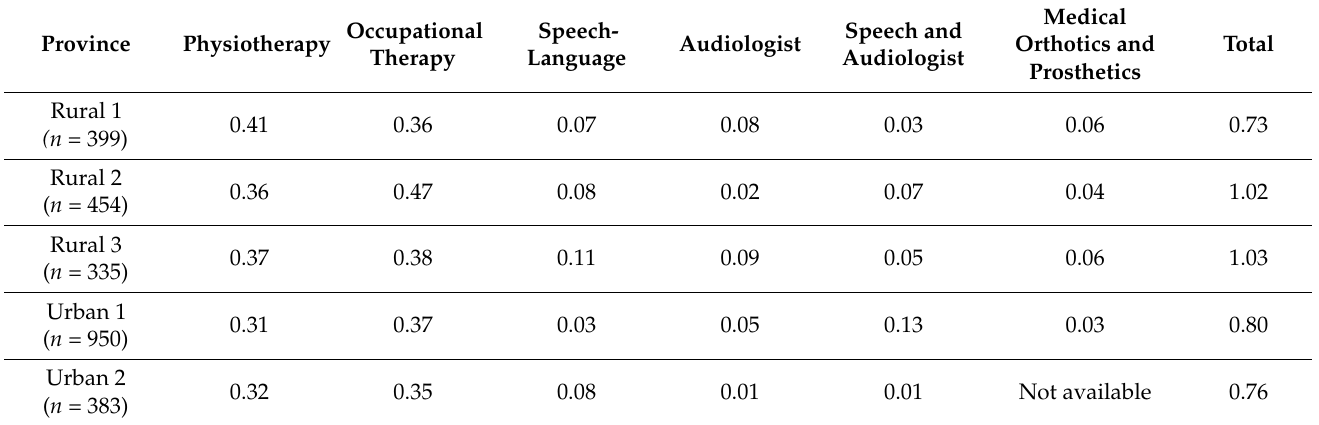
Table 1. Workforce capacity (therapists per 10 000 uninsured